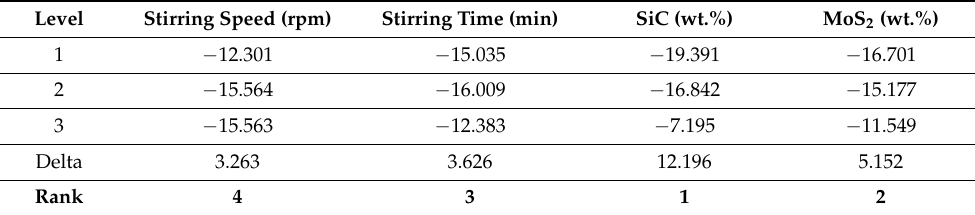
Table 10. Experimental results and S/N ratio of hardness, tensile strength, and wear rate values. Designation